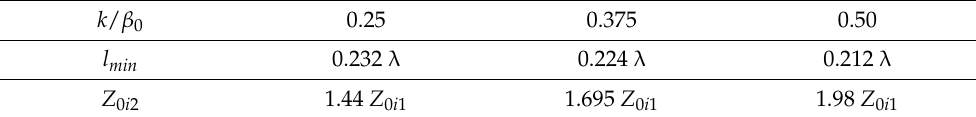
Table 1. Parameters of tapered stubs.